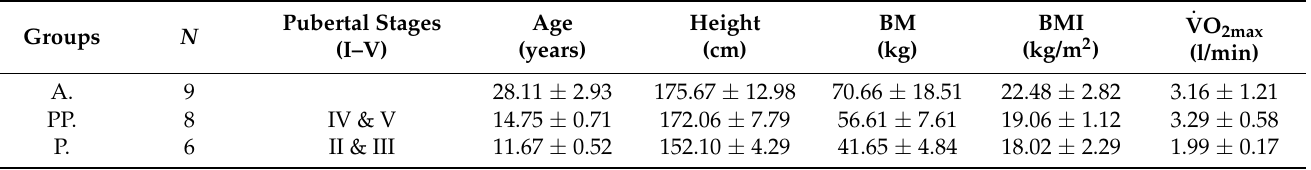
Table 1. Pubertal stages, age and anthropometric